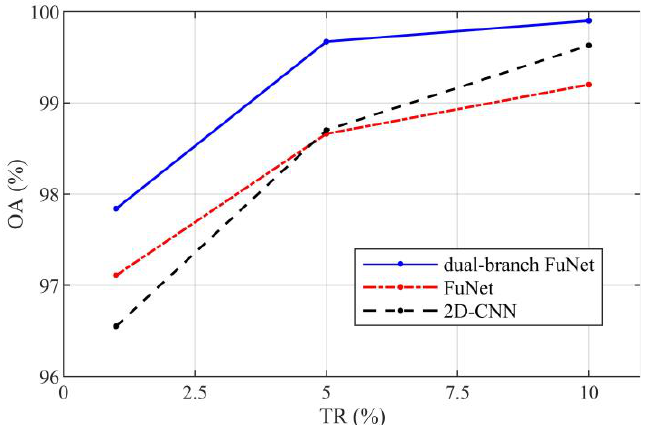
Figure 11. Classification OAs of superior networks with different training ratios on AIRSAR Flevoland data.